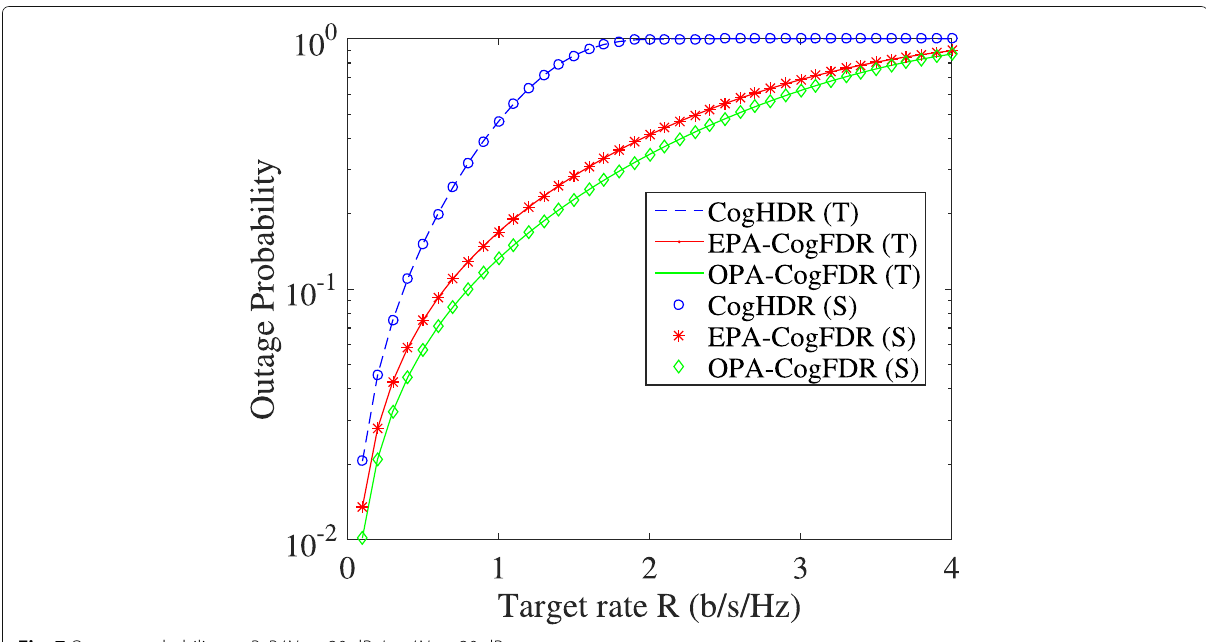
Fig. 7 Outage probability vs. R ; P / N 0 = 20 dB; I avg / N 0 = 20 dB